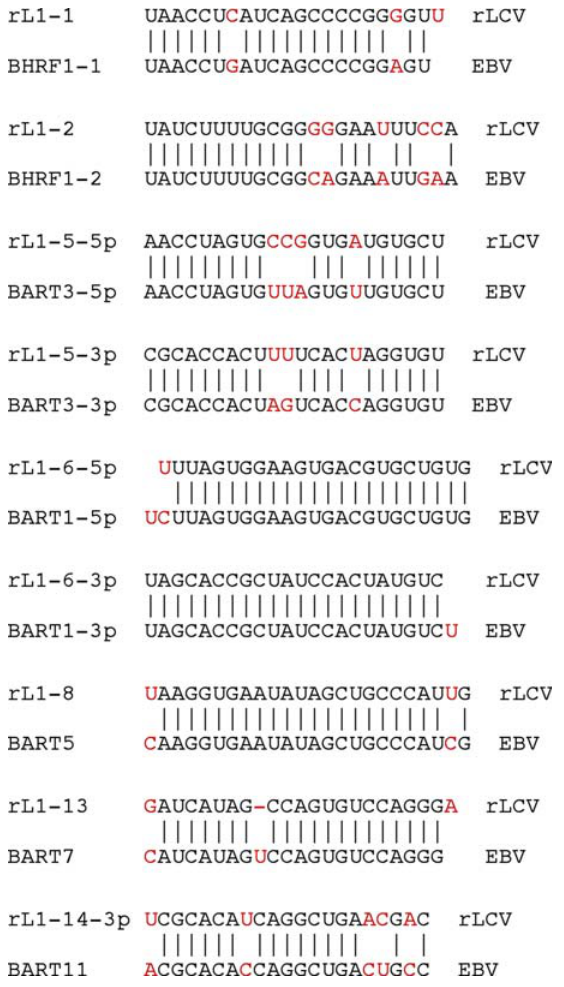
Figure 5. Sequence Comparison of miRNAs That Are Evolutionarily Conserved in EBV and rLCV and Expressed in Virus-Infected Cells All the indicated miRNAs were cDNA cloned from infected cells except miR-rL1-2, whose existence was predicted in silico and then confirmed by Northern analysis (Figure 4). DOI: